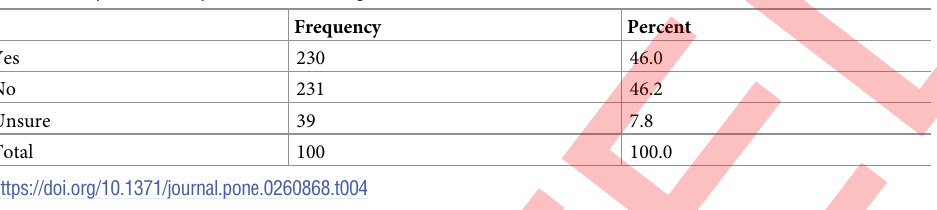
Table 4. Do you know anyone who have dengue fever